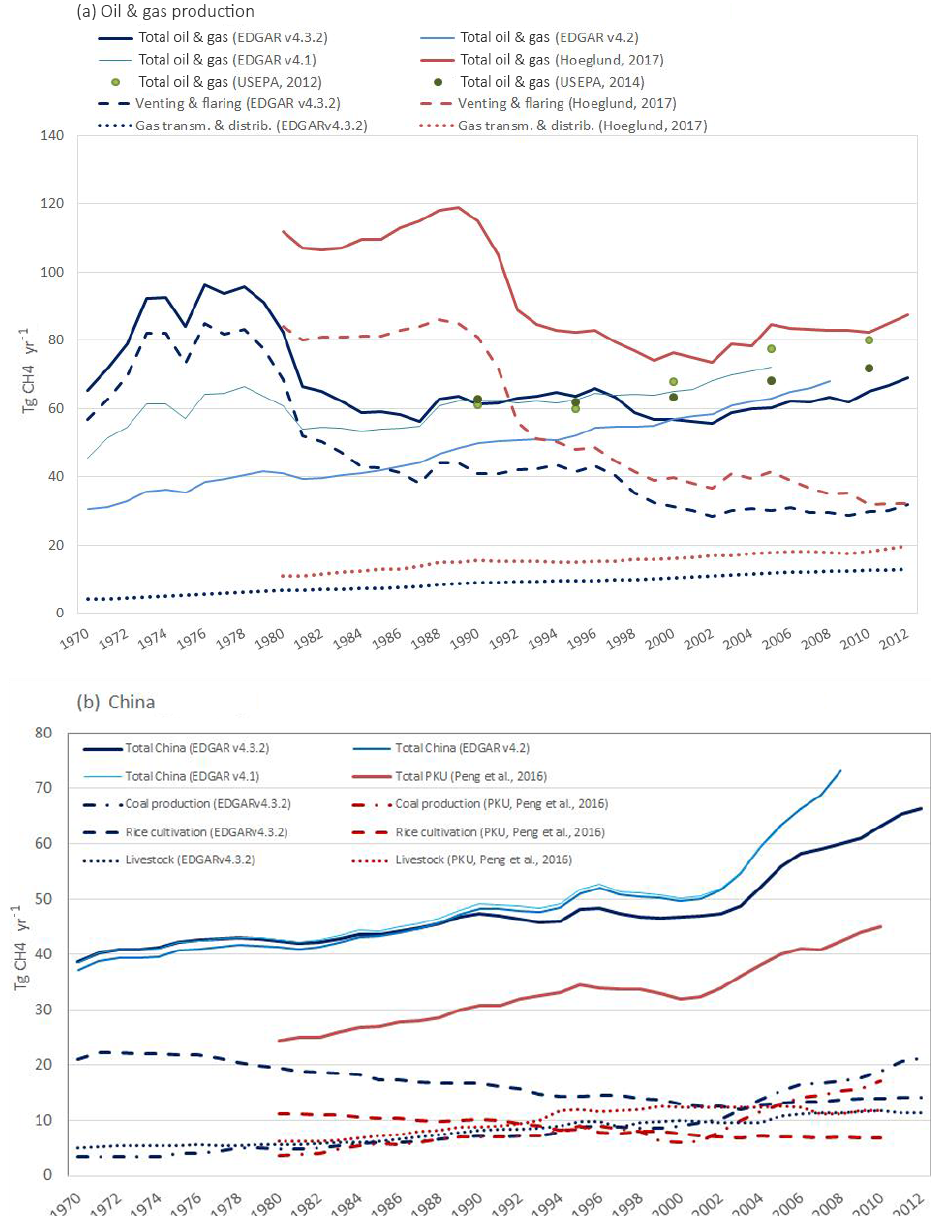
Figure 7. Intercomparison of CH 4 emissions trends estimated by different versions of EDGAR and by others with (a) details for the CH 4 venting for oil and gas extraction, transmission and distribution with data of Höglund-Isaksson (2017) and (b) details for China’s sector- specific emissions with data of Peng et al.